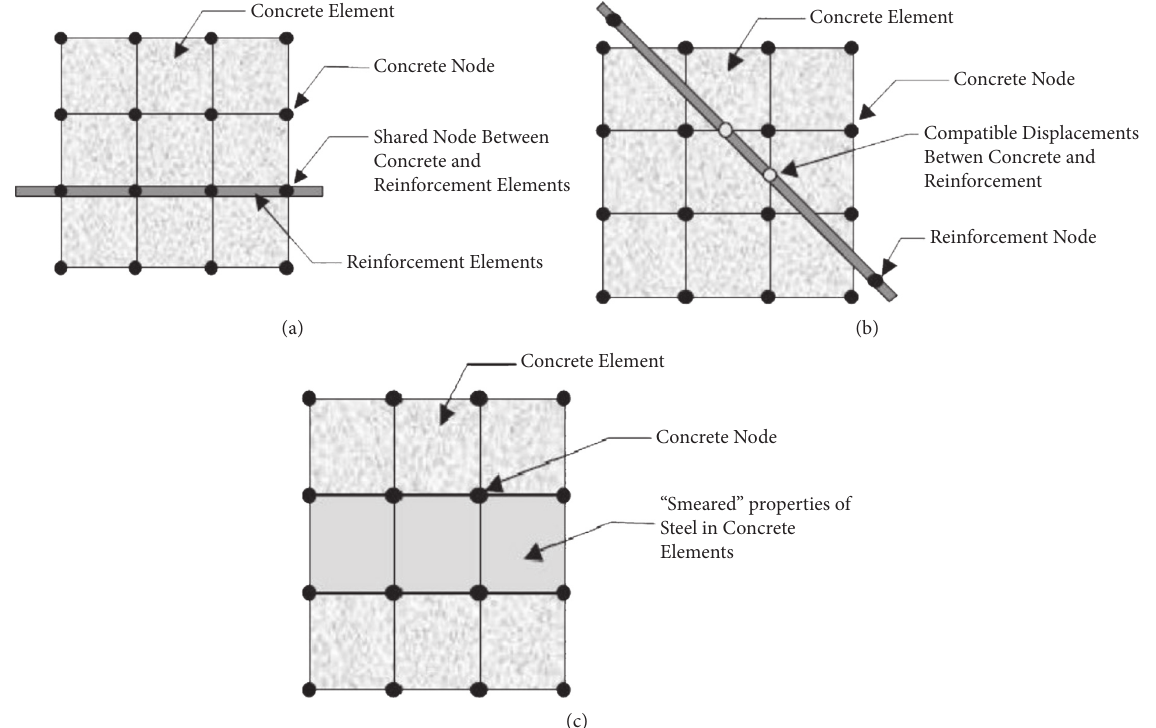
Figure 4: Steel fibres’ models [31]: (a) smeared model, (b) embedded model, and (c) discrete model.